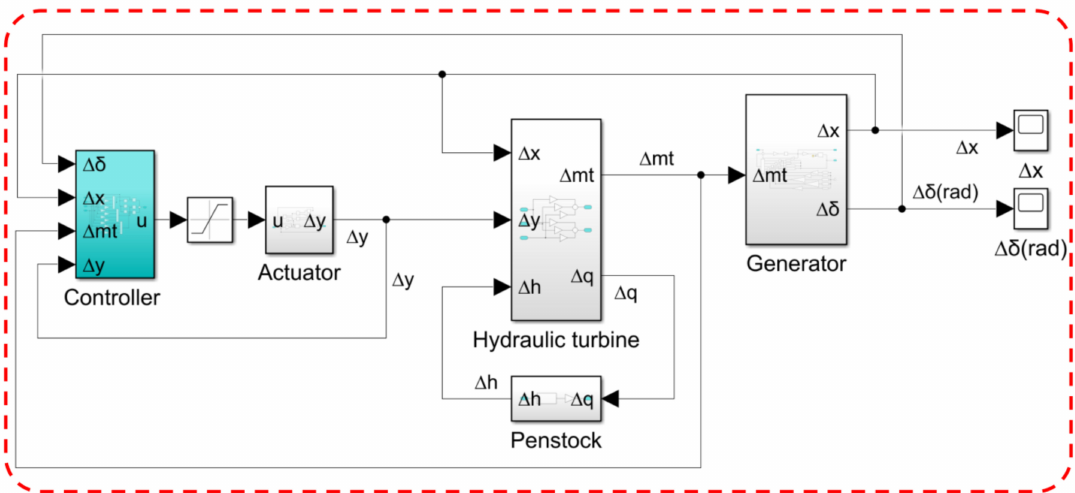
Figure 12. Simulation model of HTGS.